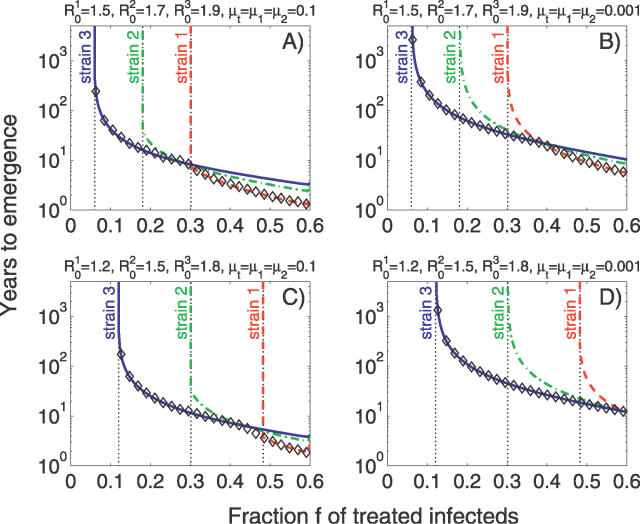
Years until Resistance Emerges—Deterministic ModelThe black diamonds show the earliest time at which any one of the resistant strains emerges (reaches a level of 5% of total infecteds), obtained from simulations of the full deterministic system (Equation 1). The red dashed, green dash-dotted, and blue solid lines show the analytic approximation (Equation 7) for the time to emergence of the first, second, and third resistant strain. The vertical black lines indicate the level of treatment at which the fitness (R
0) of the respective resistant strain is the same as that of the sensitive. For the top panels, fitness levels of the resistant strains are 75%, 85%, and 95% of the sensitive strain in the absence of treatment, resulting in values for the basic reproductive numbers as indicated. For the bottom panels, fitness levels of the resistant strains are 60%, 75%, and 90% of the sensitive strain. The left panels show results for conversion rates μt = μ
1 = μ
2 = 10−1, the right panels show results for μt = μ
1 = μ
2 = 10−3. Other parameter choices are given in Table 1.